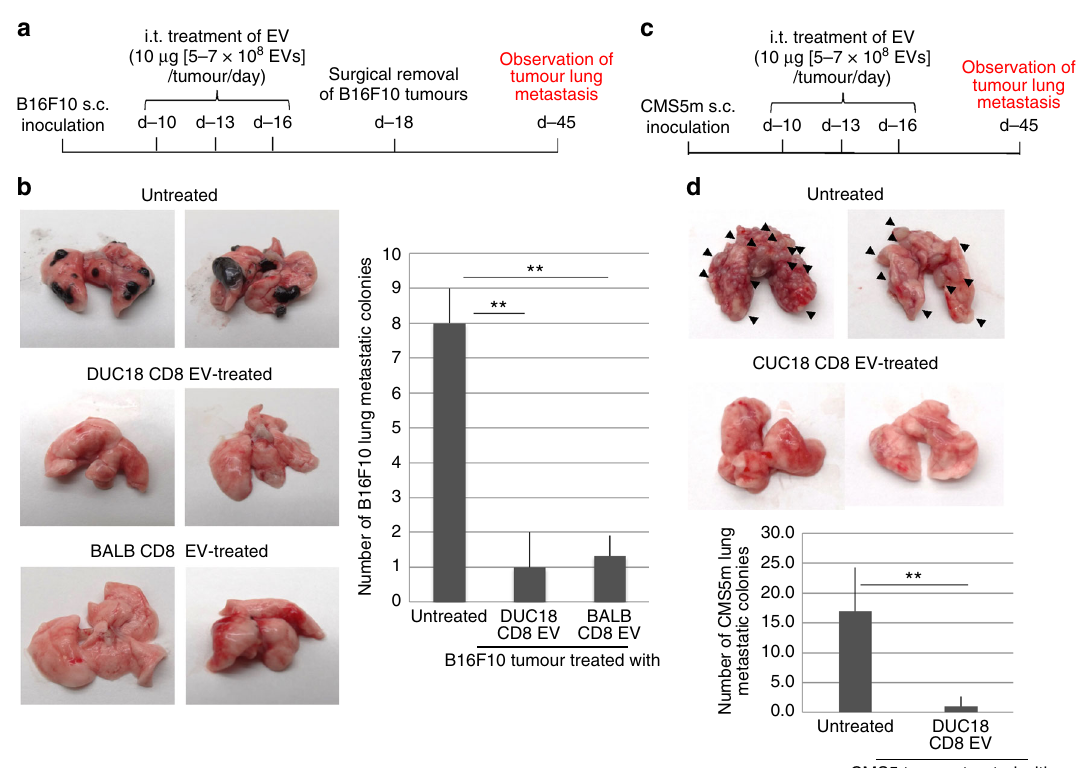
Fig. 5 Inhibition of tumour metastasis by i.t. treatment of CD8 + T cell EVs. a Time schedule of the observation of B16F10 lung metastasis. b Lung metastasis of B16F10 tumours on day 45 from the indicated groups ( n = 7 per group) was examined, and the numbers of metastatic tumour colonies were counted (** p < 0.01; error bars indicate SEM). The data were analysed by two-tailed unpaired Student t -test. c Time schedule of the observation of CMS5m lung metastasis. d Lung metastasis of CMS5m tumours on day 47 ( n = 6 per group) from the indicated groups was examined, and the numbers of metastatic tumour colonies were counted (** p < 0.01; error bars indicate SEM). The data were analysed by a two-tailed unpaired Student t